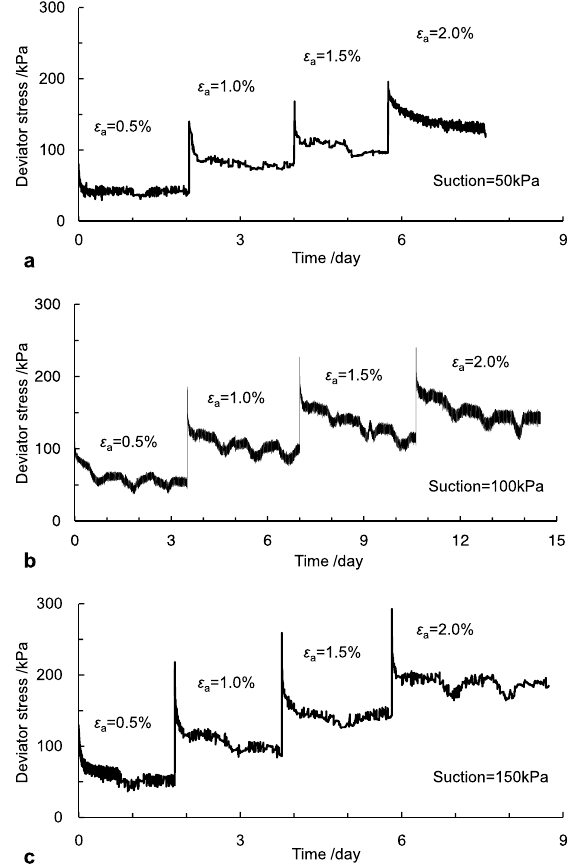
Figure 4. The measured stress relaxation curves: ( a) suction = 50 kPa, ( b) suction = 100 kPa and ( c) suction = 150